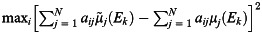
Convergence analysis.Maximum quadratic errors maxi∑j = 1Naijμ~j(Ek)-∑j = 1Naijμj(Ek)2 in each energy channel versus the number of iterations in the case of PEER = 1.The y-axis is on a log scale.